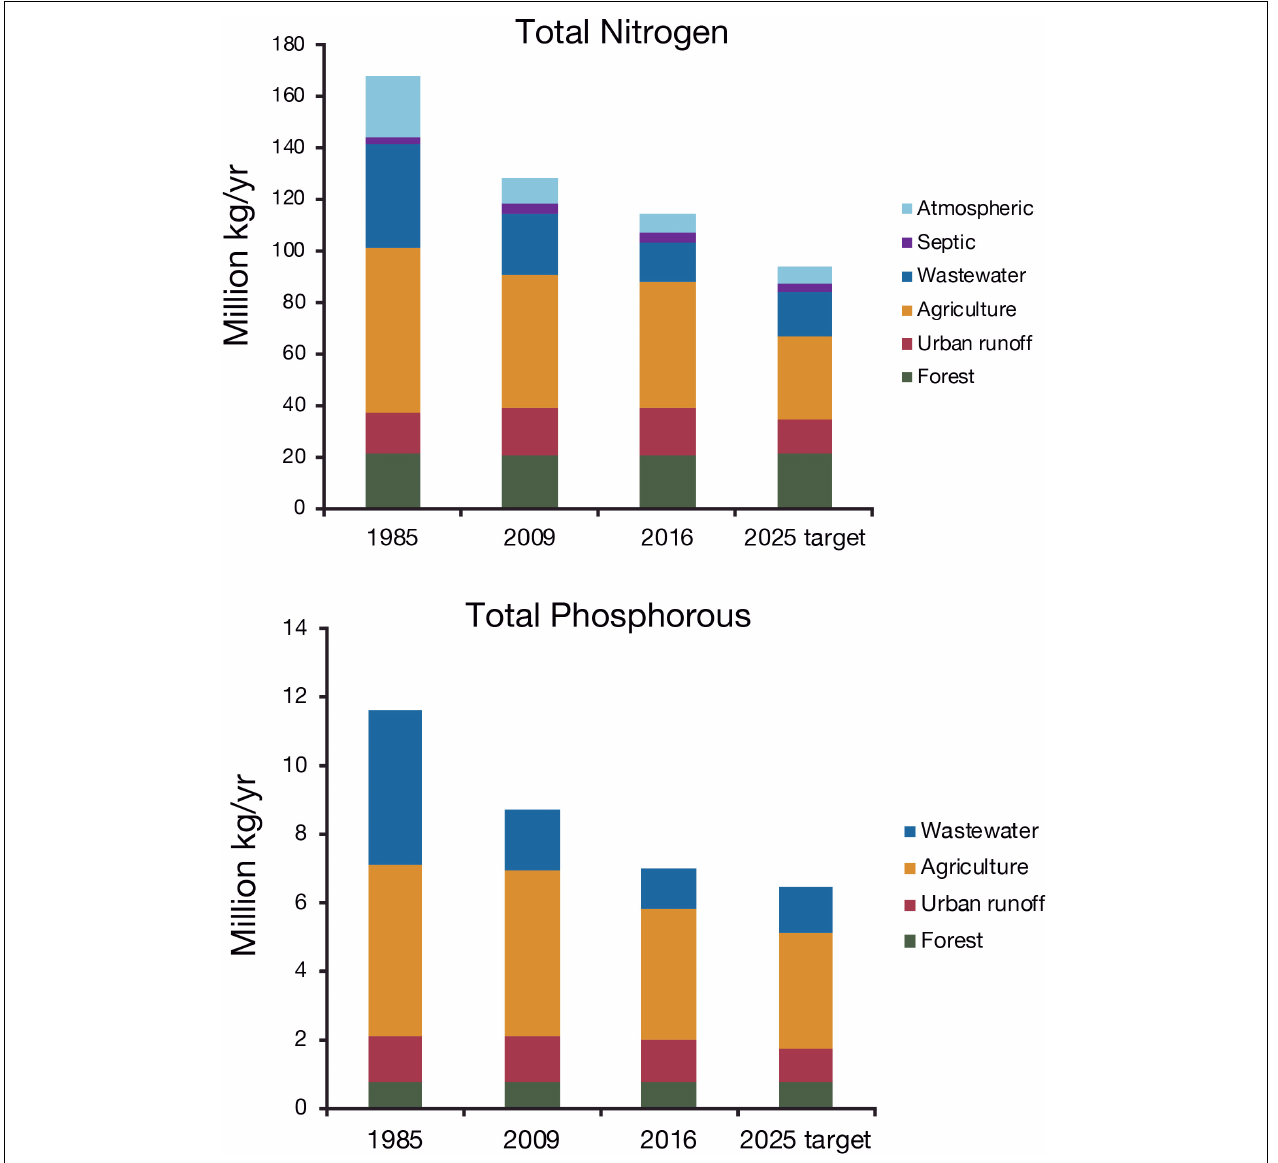
FIGURE 3 | Estimated loading of total nitrogen and total phosphorus to the Chesapeake Bay, United States, around 1985 (before the campaign to reduce nutrient loads), 2008 and 2016 compared to the Total Maximum Daily Load targets to be achieved by 2025. Based on Phase 5.3.2 watershed model and derived from https://www.chesapeakeprogress.com/clean-water/watershed-implementation-plans; accessed on 12 February